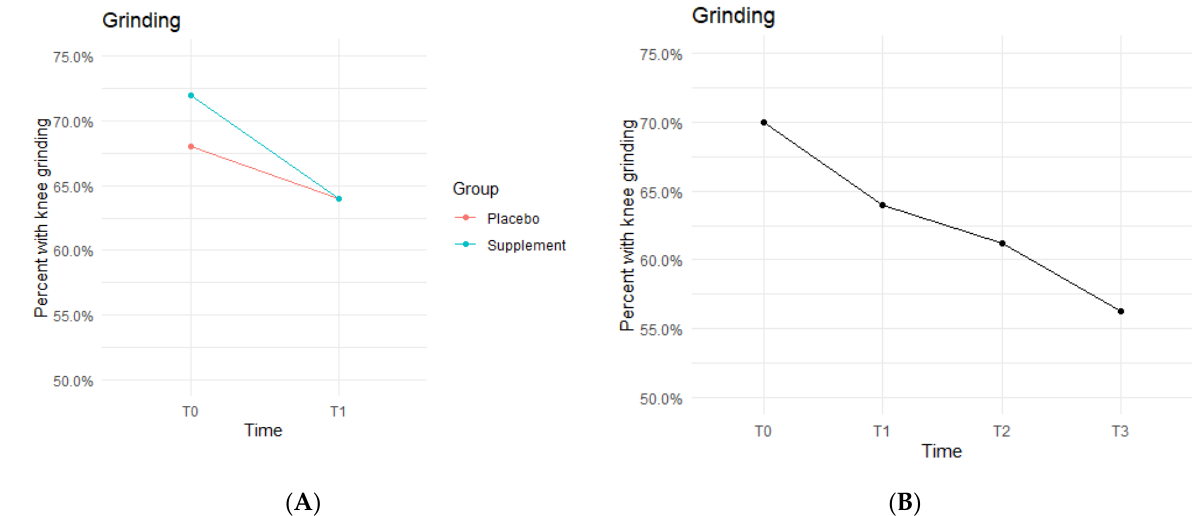
Figure 6. Knee Grinding Changes Over Time. Average percentages of participants experiencing grinding were graphed on a plot. ( A ) compares Supplement vs. Placebo from T0 to T1. ( B ) shows averages for the entire cohort as a whole at times T0, T1, T2, and T3. Only affected knees were included in the data.